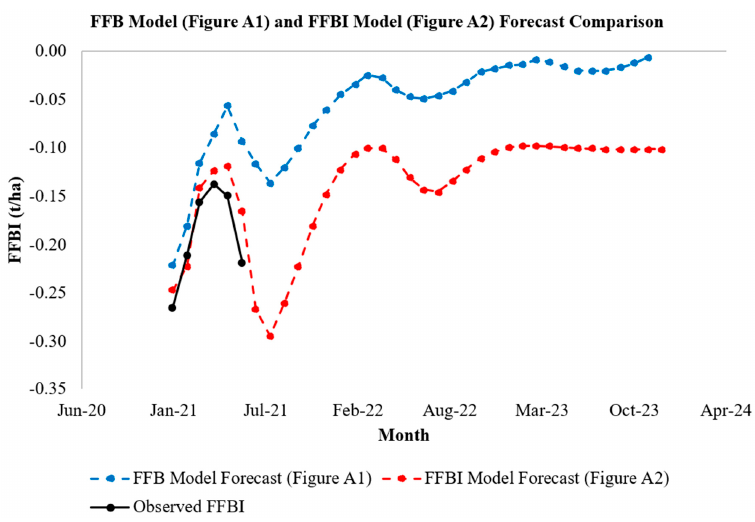
Figure A4. Predicted values from 2021 to 2023 (N = 36) using FFB model (Figure A1) and proposed FFBI model (Figure A2) were compared to observed FFBI from January 2021 to June 2021 (N =